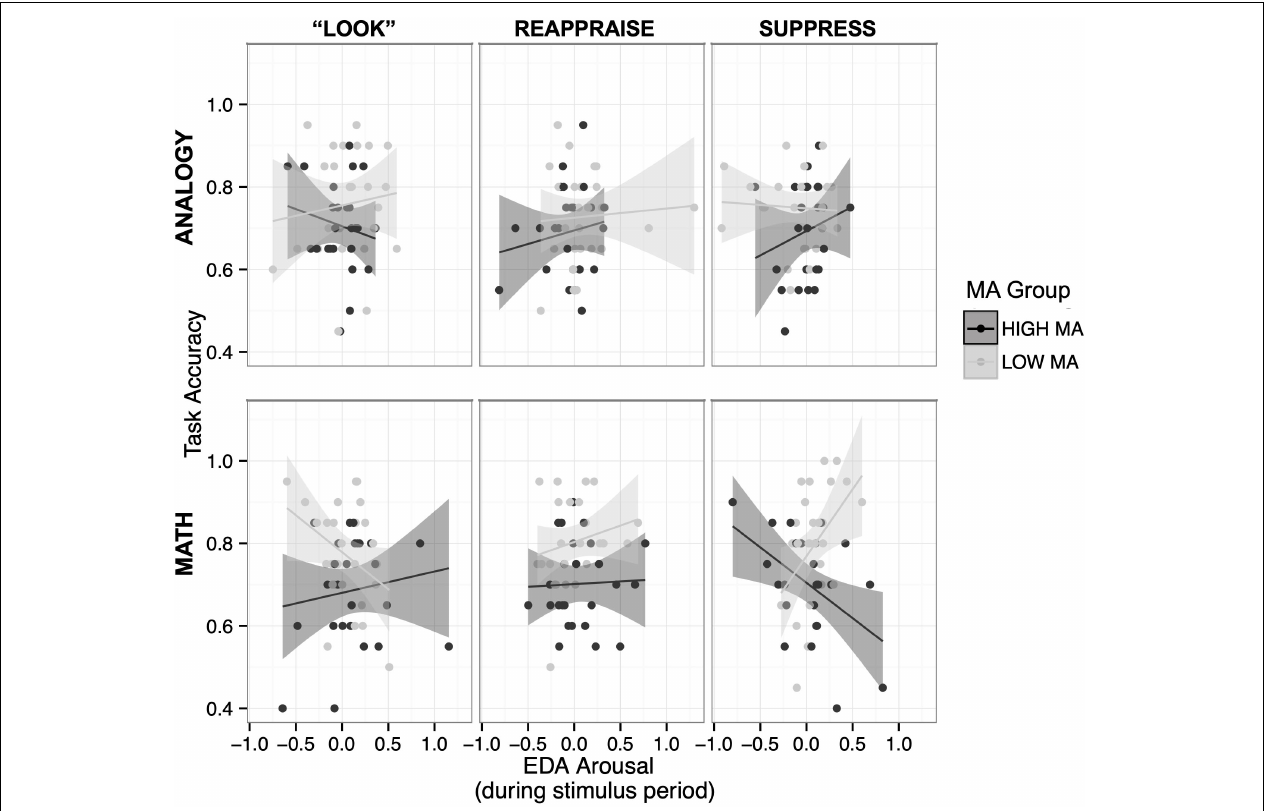
FIGURE 3 | Accuracy scores determined by 4-way interaction between MA group, stimulus type, ER strategy, and physiological arousal (EDA). When examining the effects of math anxiety, EDA, task, and ER strategy on task accuracy, we find a 4-way interaction, χ 2 (2) = 15.69, p = 0.0003. Whereas HMA and LMA groups differ significantly across “Look” and ES instructions, CR reduces the association between arousal on math performance for both groups, indicating that CR is an effective strategy for HMA individuals to reduce the harmful effects of anxiety on math